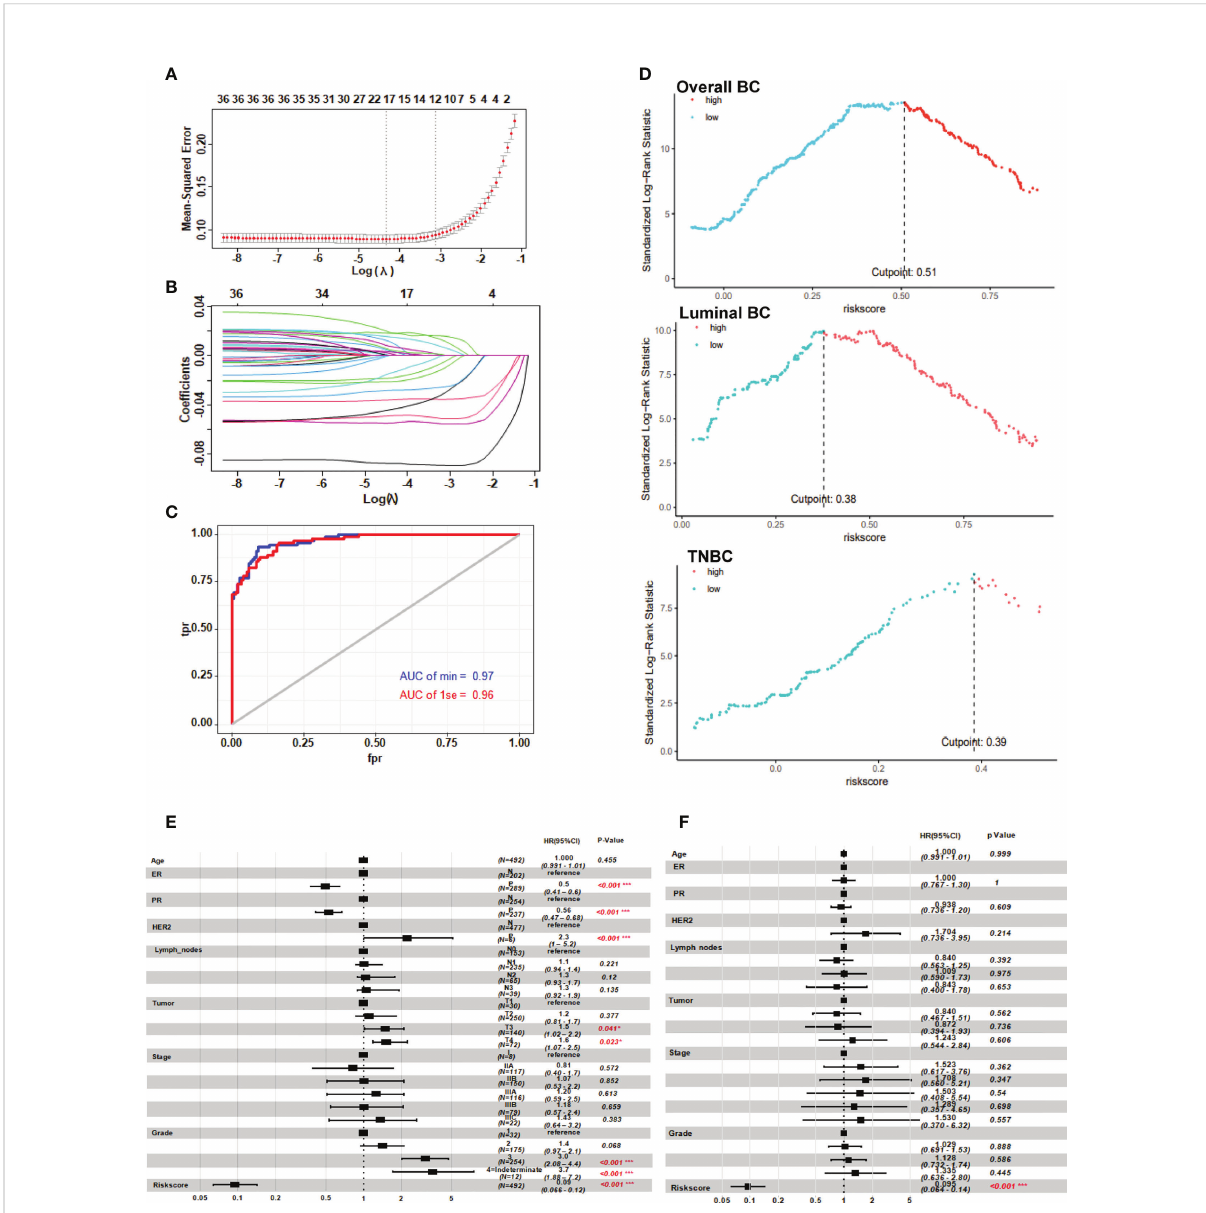
FIGURE 3 Risk model with neoadjuvant chemotherapy response based on the GGI level between the two clusters. (A, B) LASSO regression prognostic model of patients with breast cancer treated with NAC (n=246). (C) ROC analysis of the risk score in patients with breast cancer treated with neoadjuvant chemotherapy. (D) Cutoff of the risk score in patients with breast cancer treated with NAC. (E, F) Univariate and multivariate analysis of the twelve-gene NAC response risk model. *P < 0.05; and ***P <